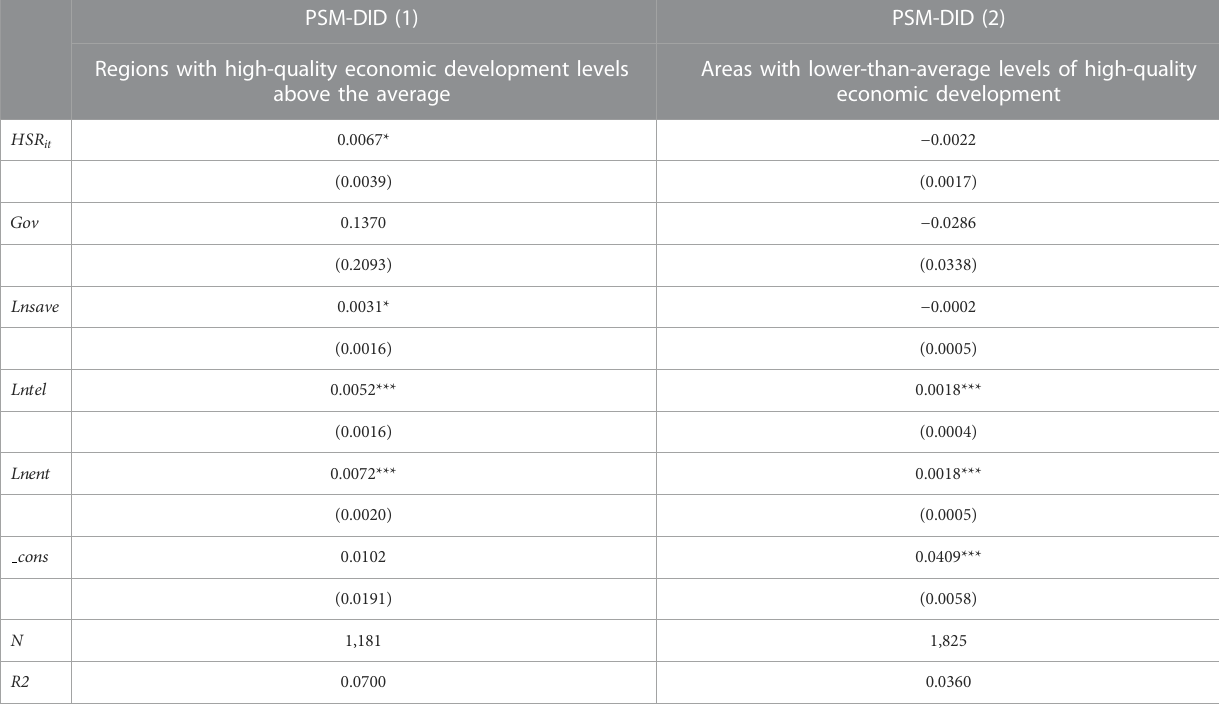
TABLE 13 Heterogeneity in the level of high-quality economic